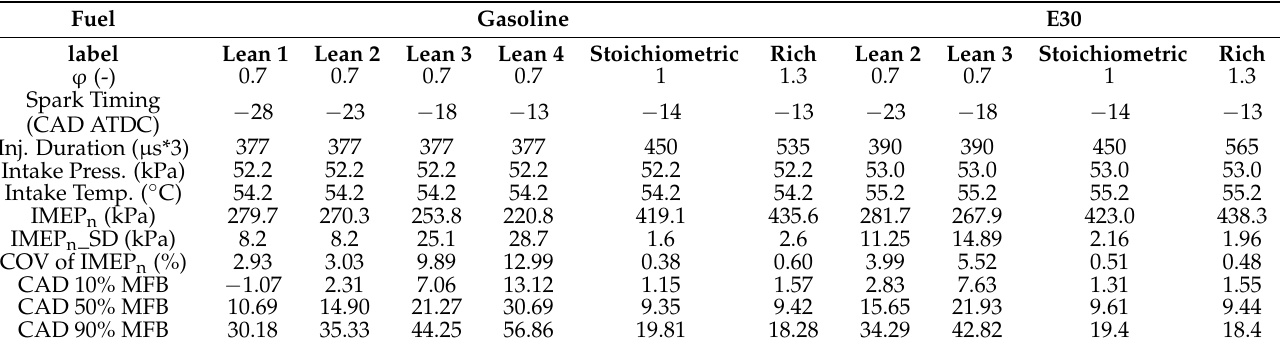
Table 4. Operating conditions of the engine in its optical configuration for well-mixed mode combustion analysis. Engine speed is 1000